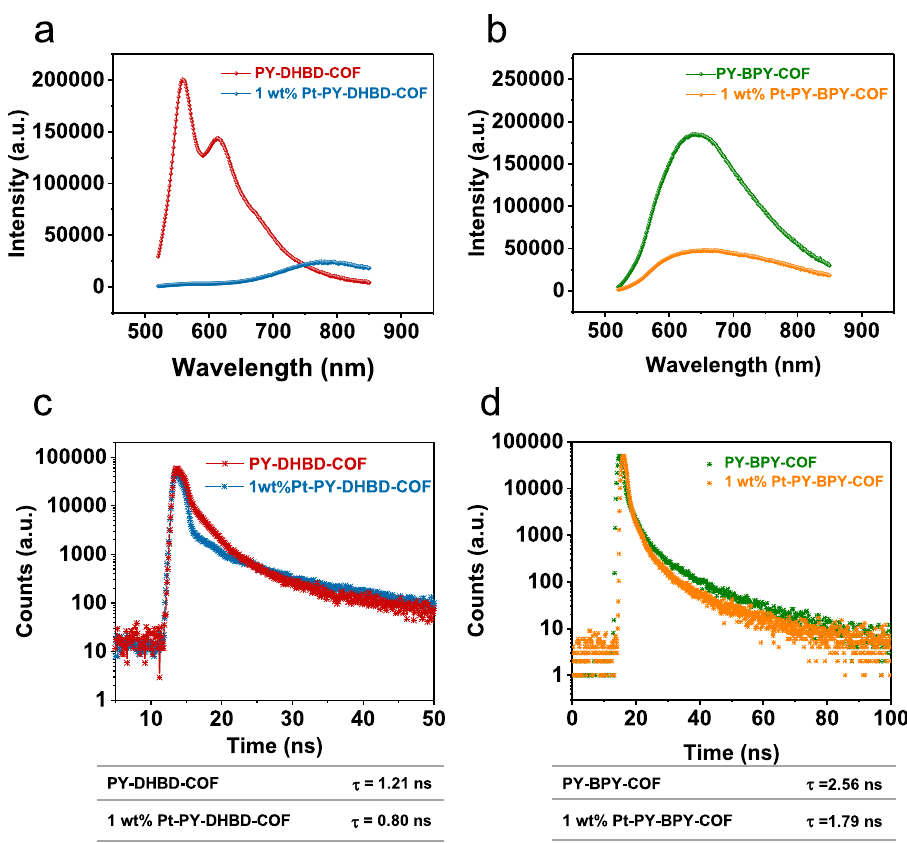
Fig. 7 Fluorescence emission and lifetime of the typical samples. a , b Fluorescence spectra and c , d fl uorescence lifetime decay of PY-DHBD-COF, PY- BPY-COF and the corresponding Pt (1 wt%) loaded samples. PY-DHBD-COF and PY-BPY-COF were excited with a λ ex = 374 nm laser and the emissions were measured at 560 nm and 620 nm,